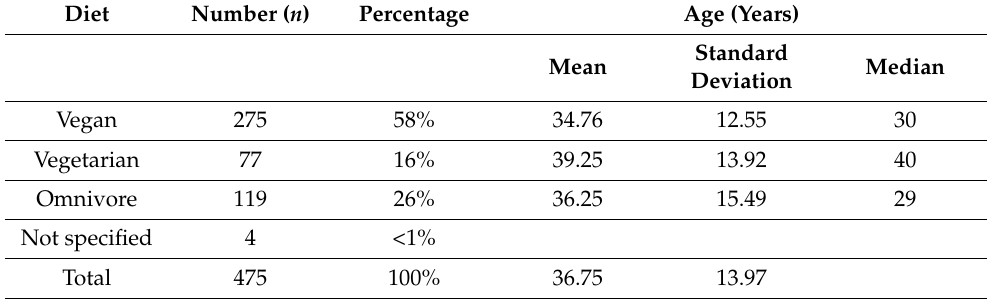
Table 2. Type of diet and